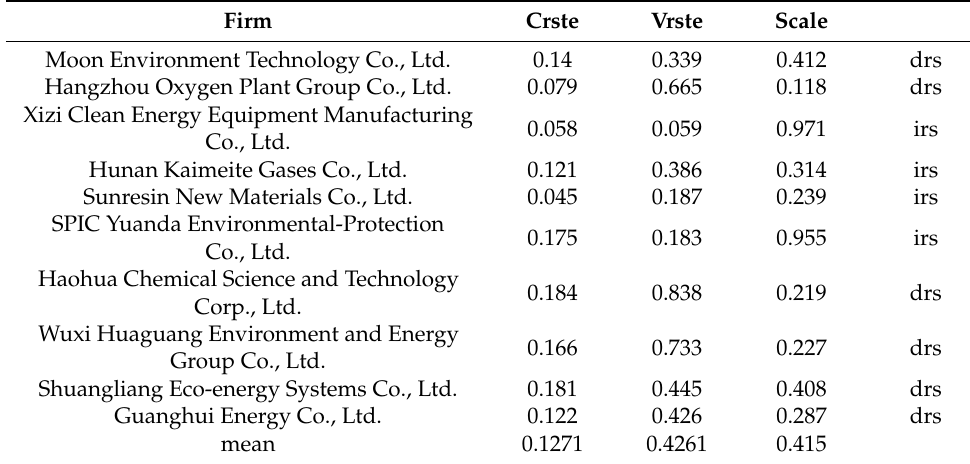
Table 4. 2019 Enterprise